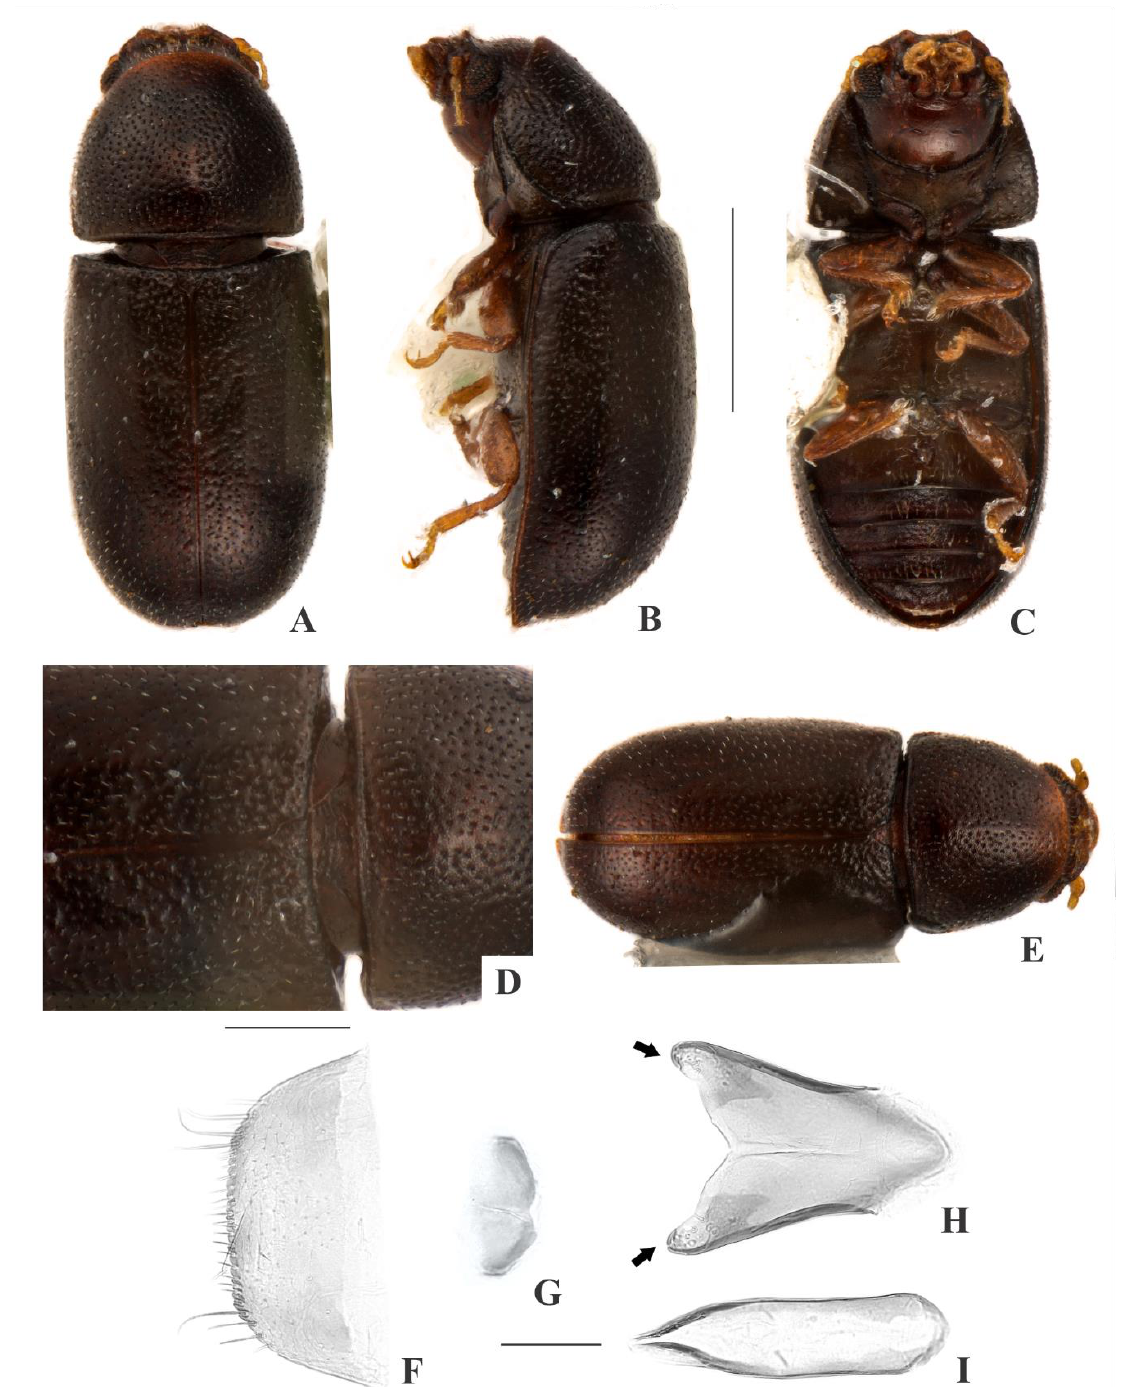
Figure 8. Cis parvisetosus sp. n. , male holotype ( A – D ), female paratype ( E ), aedeagus of paratype from type locality ( F – I ): ( A ) Dorsal view. ( B ) Lateral view. ( C ) Ventral view. ( D ) Scutellar shield and part of the pronotum and elytra. ( E ) Sternite VIII. ( F ) Basal piece. ( G ) Tegmen, note shallow V-shaped emargination with rounded corners at apex (black arrows). ( H ) Penis. Scale bars: 0.5 mm ( A – C , E ), 0.2 mm ( D ), 0.05 mm ( F – I ).